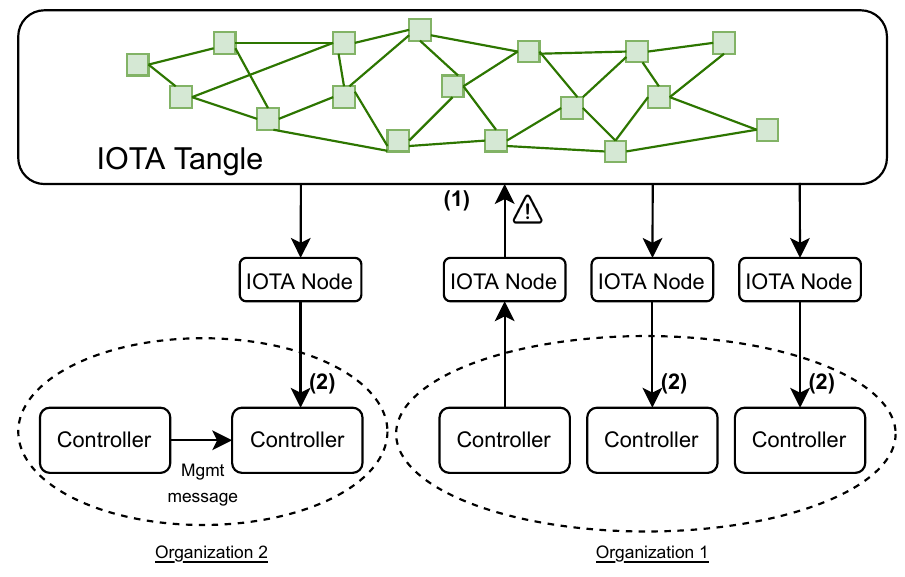
Figure 5. An example of organizations managing controllers associated with different subnets. In a federated environment, if an alert (1) is generated from a node, all interested controllers across organizations are notified